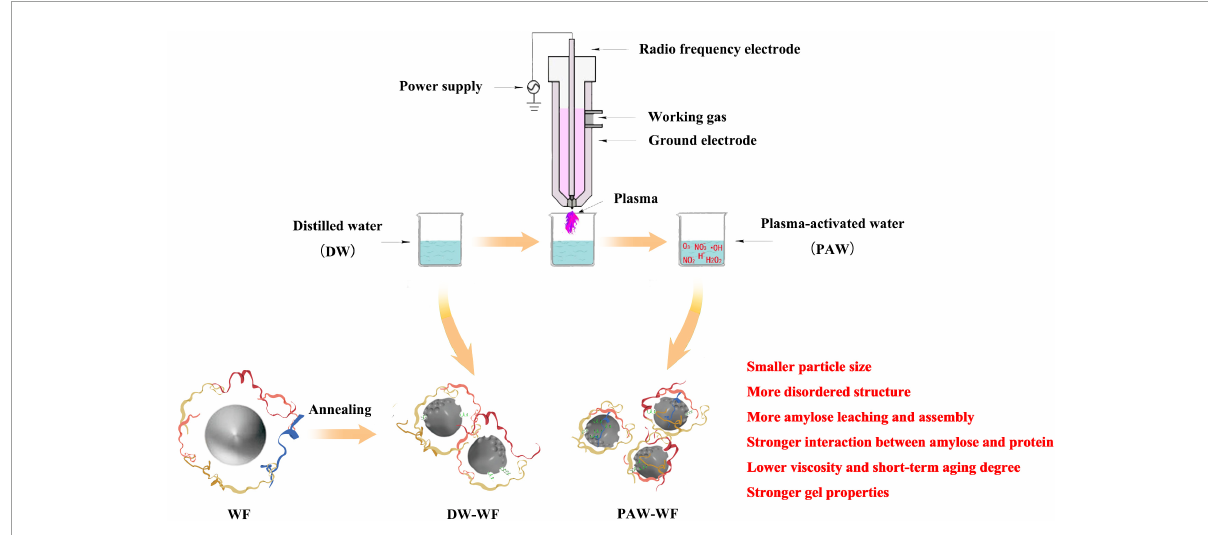
FIGURE7 Influencing mechanism of PAW-ANN on the structure and properties of WF.